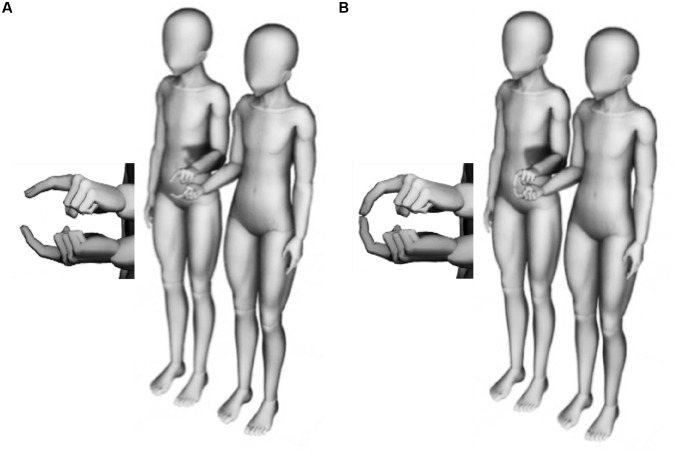
Standing conditions. Participants stood on two independent platforms, positioned side-by-side, with a space of 10 cm between the participants at the shoulder, facing in a forward direction, with eyes closed, the elbow of the partner side flexed at around 90° with the index finger extended, and the arm on the other side hanging down. The side of the taller participant was set randomly. The hand of the taller participant on the partner side was positioned above the shorter participant’s fingertip in a pronation position, and that of the shorter participant was positioned below the taller one in a supine position. The participants were instructed to stand in a relaxed manner, and postural sway was measured in the following two standing conditions: (1) the no touch (NT) condition, in which the participants kept a narrow-base standing posture in a normal bipedal position with a 5 cm interheel interval (A) and (2) the ILT condition, in addition to the NT condition, in which participants mutually touched their index fingertips (<1 N) (B). The human model drawn in Figure 1 was made by using “DesignDoll,” which may be freely used for commercial or non-commercial purposes (http://terawell.net/terawell/).